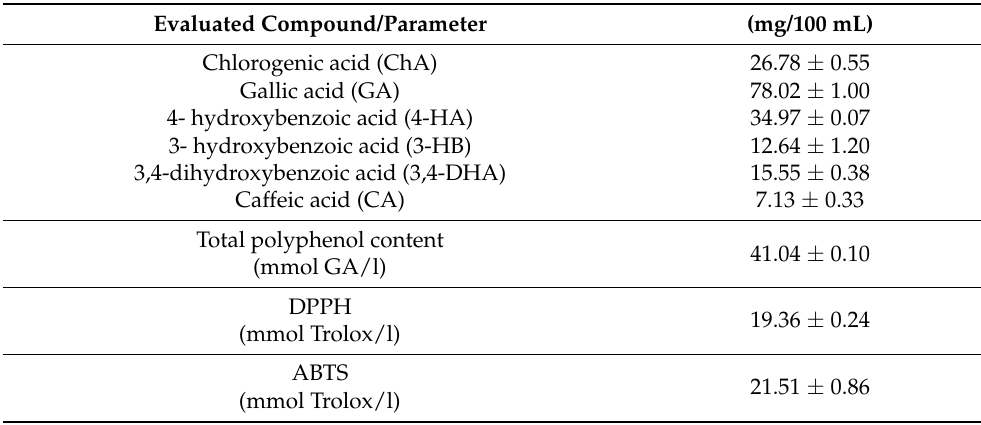
Table 1. Phenolic acid concentration, the total polyphenol content, and antioxidant activity of FEE. Mean value ± standard deviation, n = 3.